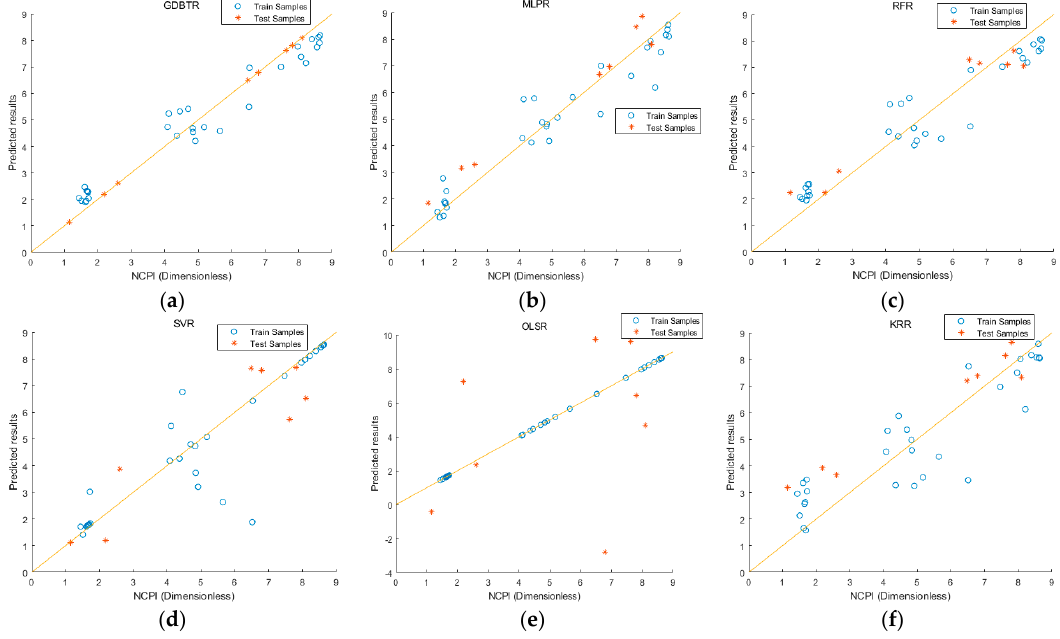
Figure 12. The scatter plots for the estimated and in-situ values in Xunsi River. ( a ) GBDTR; ( b ) MLPR;